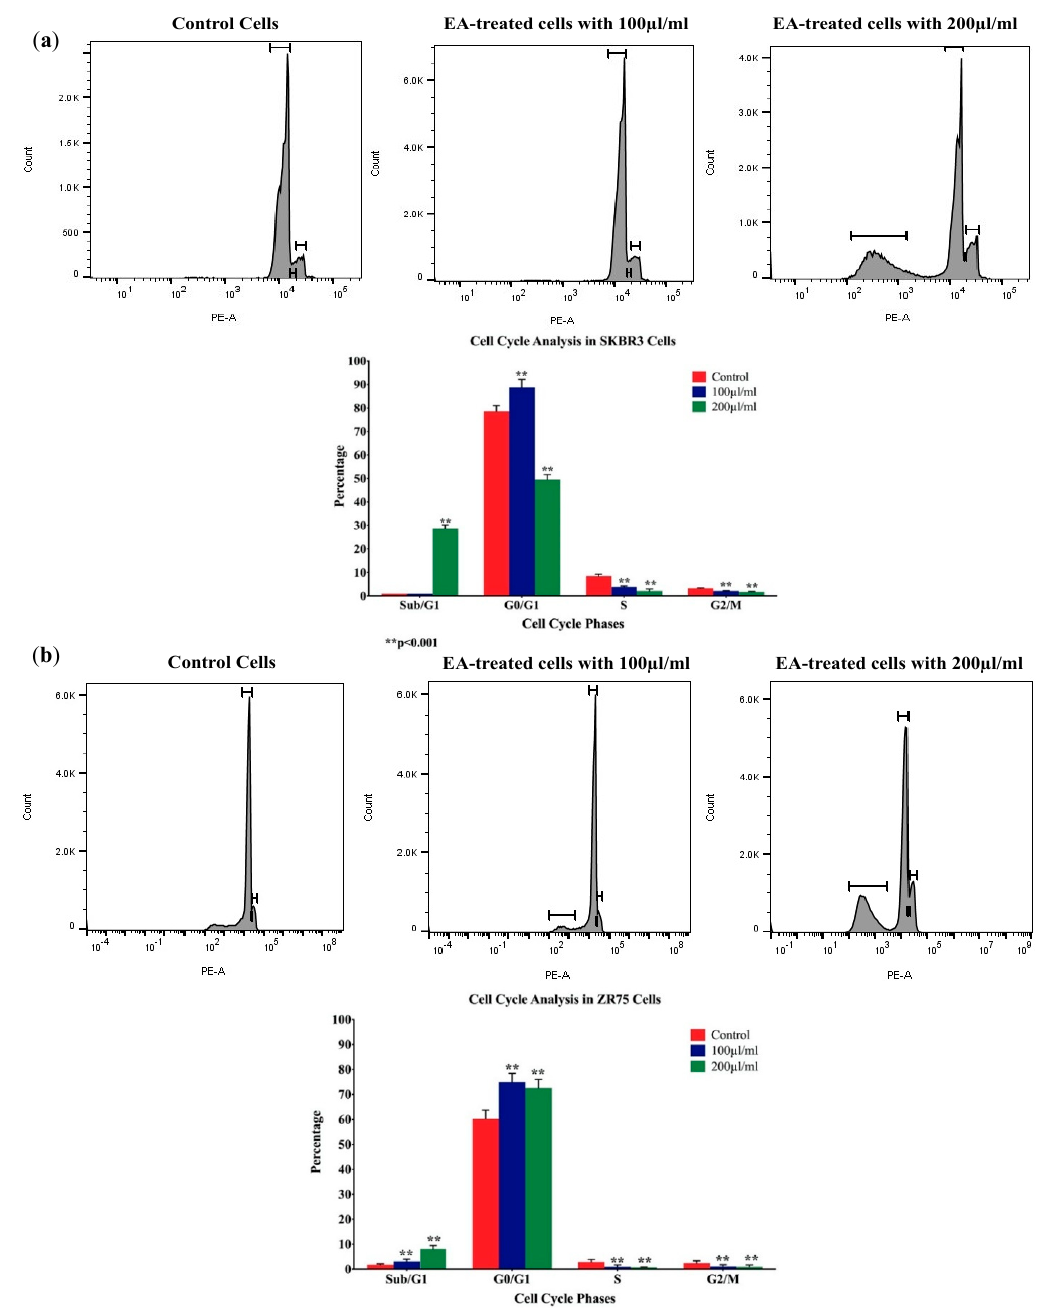
Figure 2. ( a , b ) Flow cytometry data analysis of SKBR3 and ZR75 cells after EA -treatment. Data demonstrate an increase in G 0 / G 1 phase with simultaneous reduction in S and G 2 / M phases in both cell lines. Meanwhile, there is a significant increase in cell apoptosis (Sub / G 1 phase) of SKBR3 cells treated with EA , and a small increase in cell apoptosis of treated ZR75